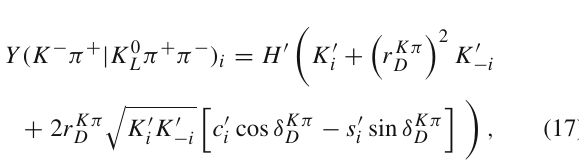
variation is given by